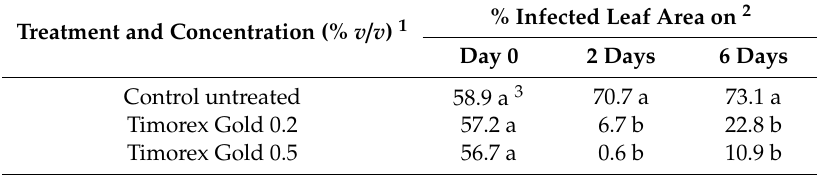
Treatment and Concentration (% v / v )